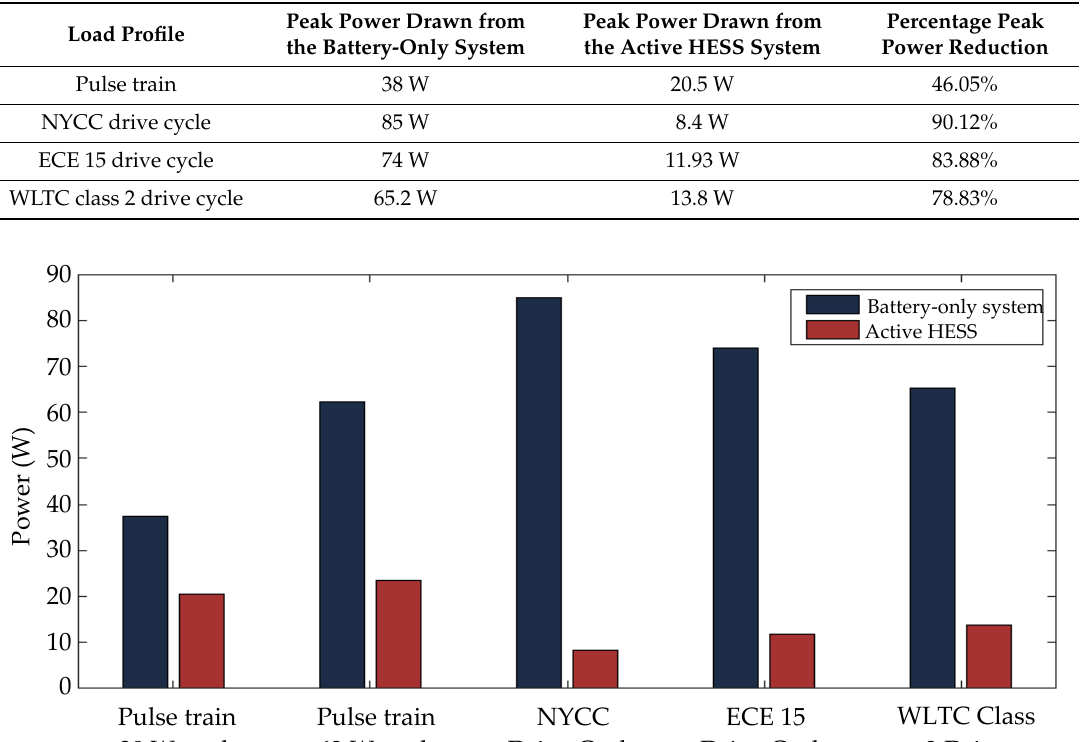
Table 6. Comparison between the peak power drawn from the battery for the battery-only system and the active HESS.